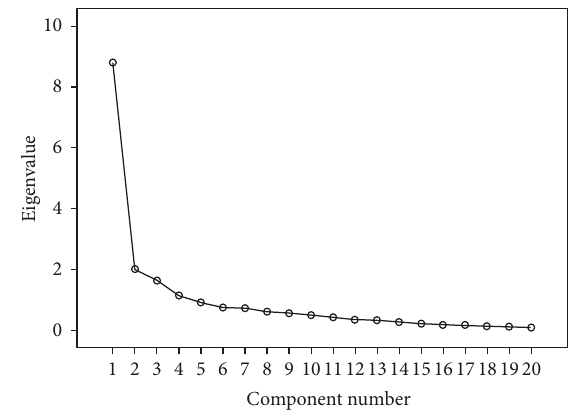
Figure 1: Scree Plot of the college